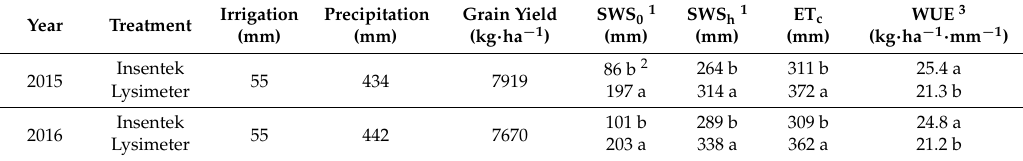
Table 5. Grain yield and estimated soil water storage, crop evapotranspiration, and water use efficiency using the Insentek and lysimetric methods, at the Xuchang Irrigation Experiment Station in 2015 and